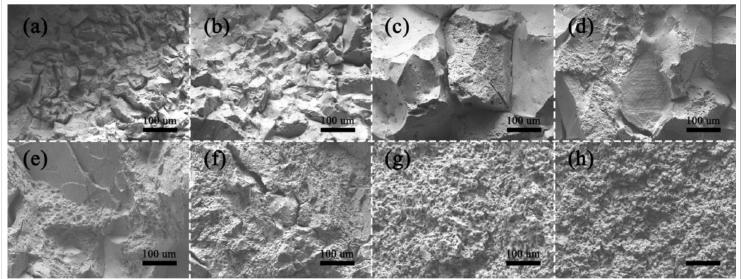
Figure 8. Fracture morphology of heat-treated stainless steel samples with the addition of ( a ) 0 ppm, ( b ) 500 ppm, ( c ) 750 ppm, ( d ) 1000 ppm, ( e ) 1500 ppm, ( f ) 2000 ppm, ( g ) 3000 ppm, and ( h ) 5000 ppm of graphite.